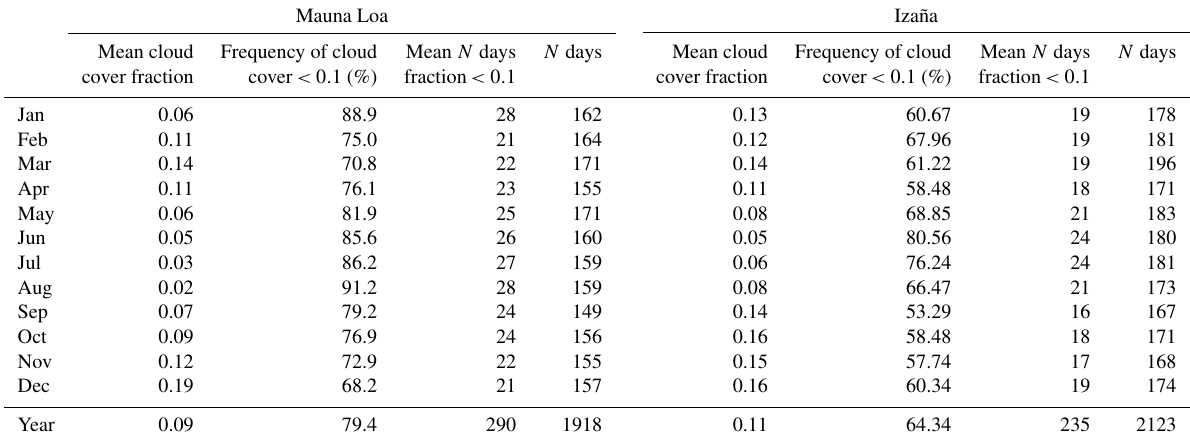
Table 1. Cloud fraction and number of clear-sky days over Mauna Loa and Izaña observatories, derived from GOME-2 cloud products (Loyola R. et al., 2010) over 2007–2014 . Clear sky is defined as a cloud fraction < 0 . 1. The number of investigated days within each month for the 8-year period is also provided.